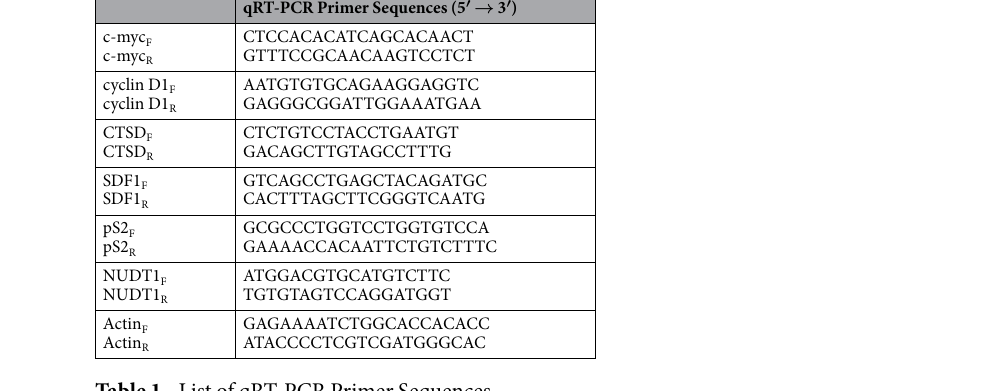
Table 1. List of qRT-PCR Primer